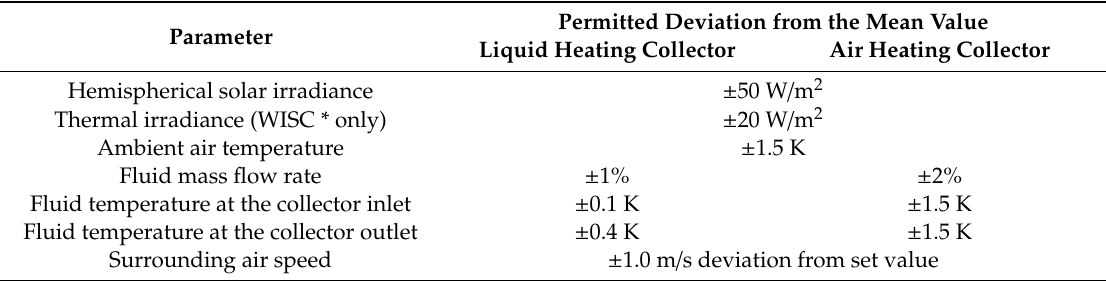
Figure 3. Experimental set up of the air-based PVT collector. ( A ) Pyrometer. ( B ) Tracker. ( C ) PVT collector. ( D ) Outlet. ( E ) Inlet. Table 2. Permitted deviation of the measured parameters during the measurement period.